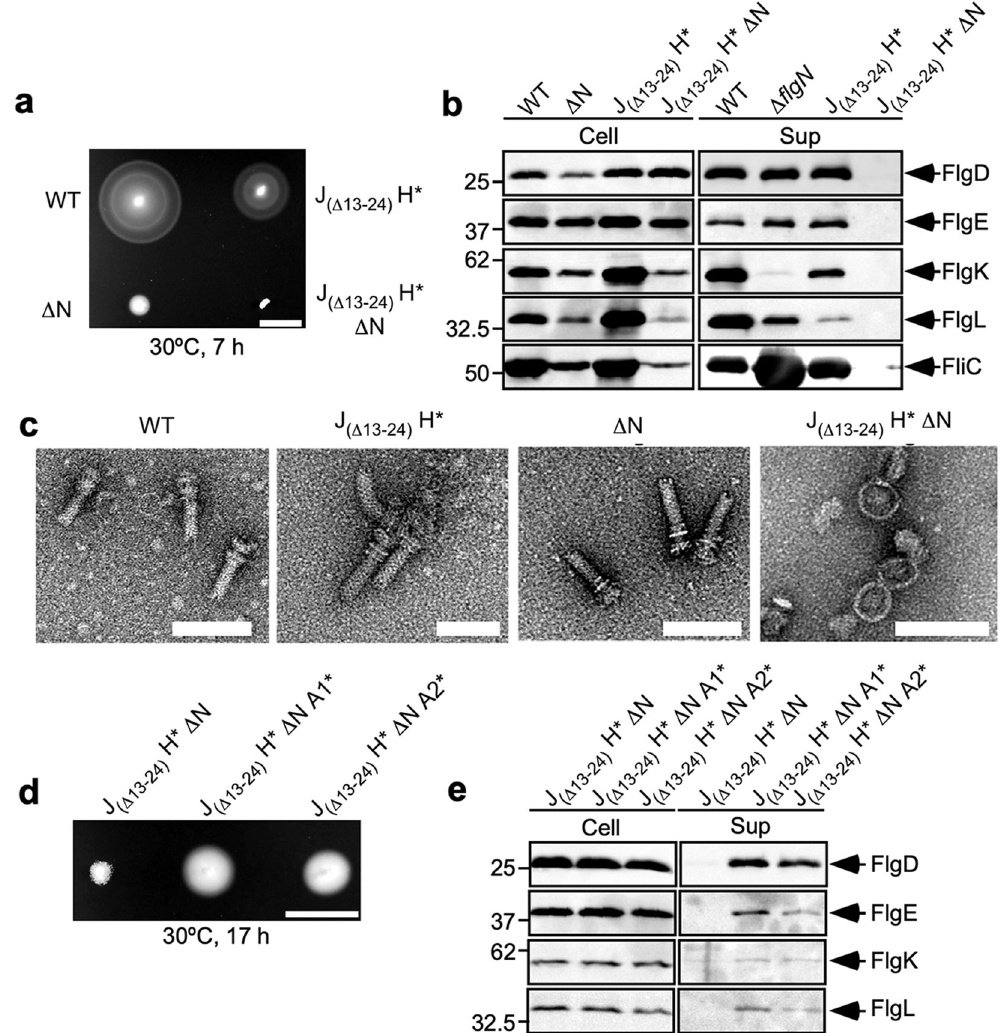
Fig. 3 Effect of FlgN deletion on fl agellar protein export by fl iJ( Δ 13 – 24 ) fl iH* cells. a Motility of SJW1103 (WT), MM104H-3 (J ( Δ 13 – 24) H * ), MM9001 ( Δ N) and MM9003 (J ( Δ 13 – 24) H * Δ N) in 0.35% soft agar plates containing 100 mM NaCl. Scale bar, 1.0 cm. b Immunoblotting, using polyclonal anti-FlgD (1st row), anti-FlgE (2nd row), anti-FlgK (3rd row), anti-FlgL (4th row) or anti-FliC (5th row) antibody, of whole-cell proteins (Cell) and culture supernatant fractions (Sup) prepared from the above strains. The regions of interest were cropped from original immunoblots shown in Supplementary Fig. 11a. c Electron micrograms of hook-basal bodies isolated from the above stains. Scale bar, 100 nm. d Motility of MM9003, MM9003-2 (J ( Δ 13 – 24) H * Δ N A1*) and MM9003-3 (J ( Δ 13 – 24) H * Δ N A2*) in 0.35% soft agar plates containing 100 mM NaCl. Scale bar, 1.0 cm. e Immunoblotting, using polyclonal anti-FlgD (1st row), anti-FlgE (2nd row), anti-FlgK (3rd row), or anti-FlgL (4th row) antibody, of whole-cell proteins (Cell) and culture supernatant fractions (Sup) prepared from the above strains. The regions of interest were cropped from original immunoblots shown in Supplementary Fig.